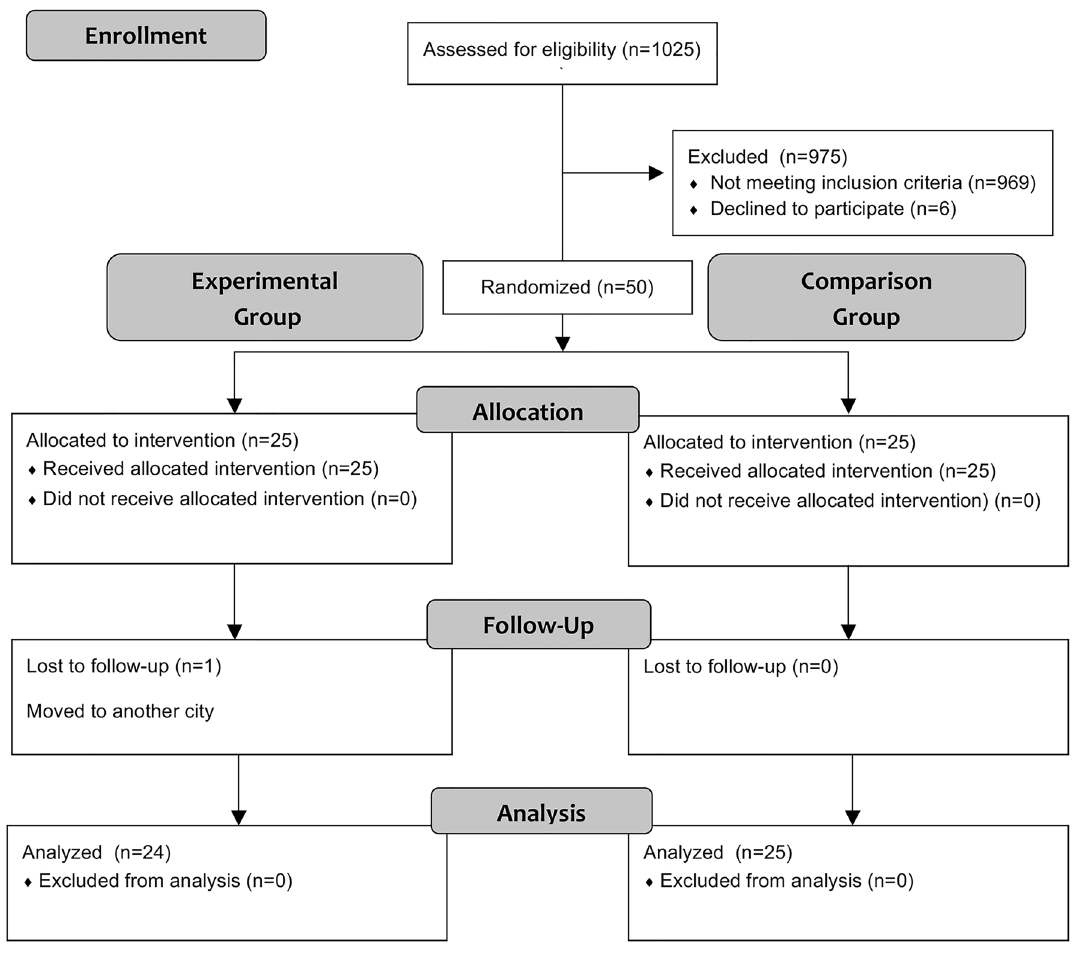
Figure 4. Consolidated standards of reporting trials flow diagram 19